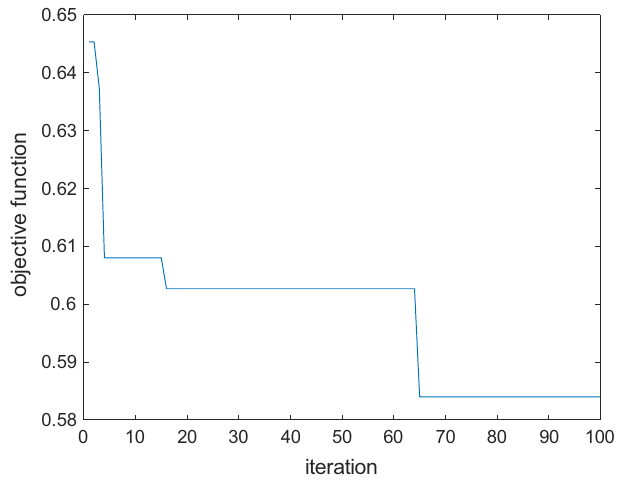
Figure 8: MFO convergence